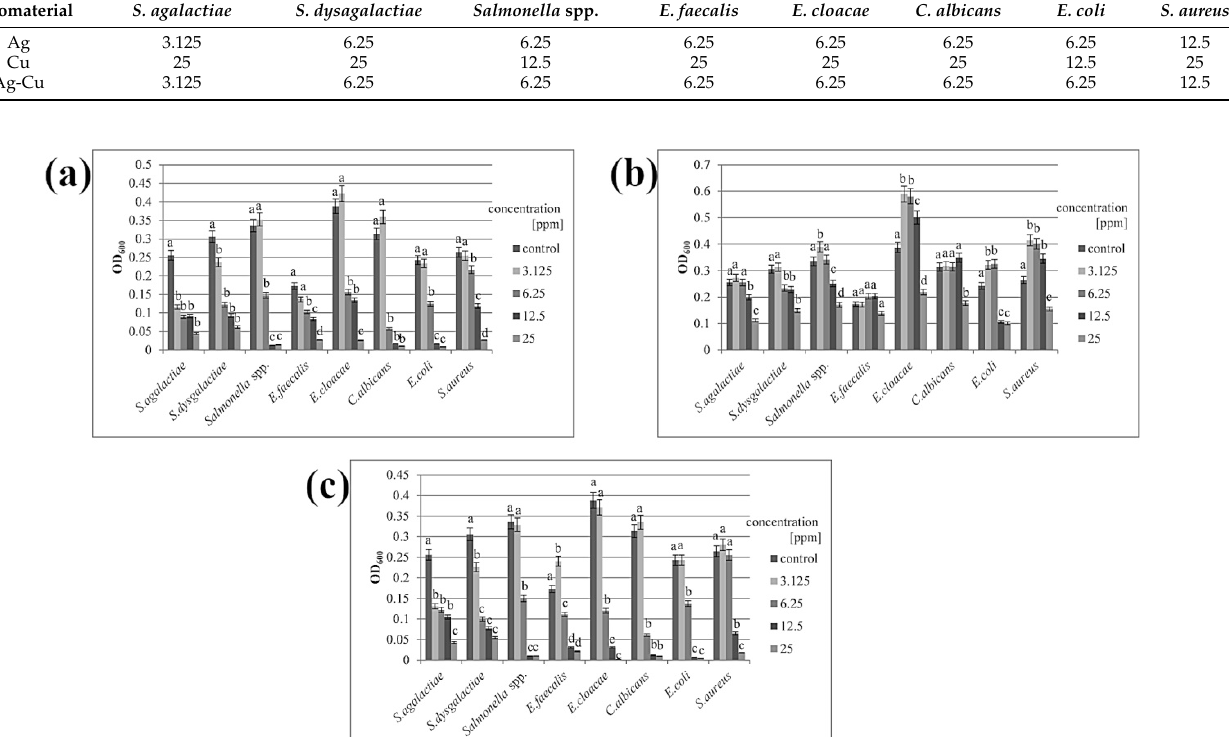
Figure 2. Optical density of microbial growth. Microbes were treated with ( a ) silver nanoparticles; ( b ) copper nanoparticles; ( c ) silver–copper complex. All samples were measured in triplicate and the results were averaged. Columns labelled a–d indicate statistically significant differences between groups within a species, and error bars show standard deviation.